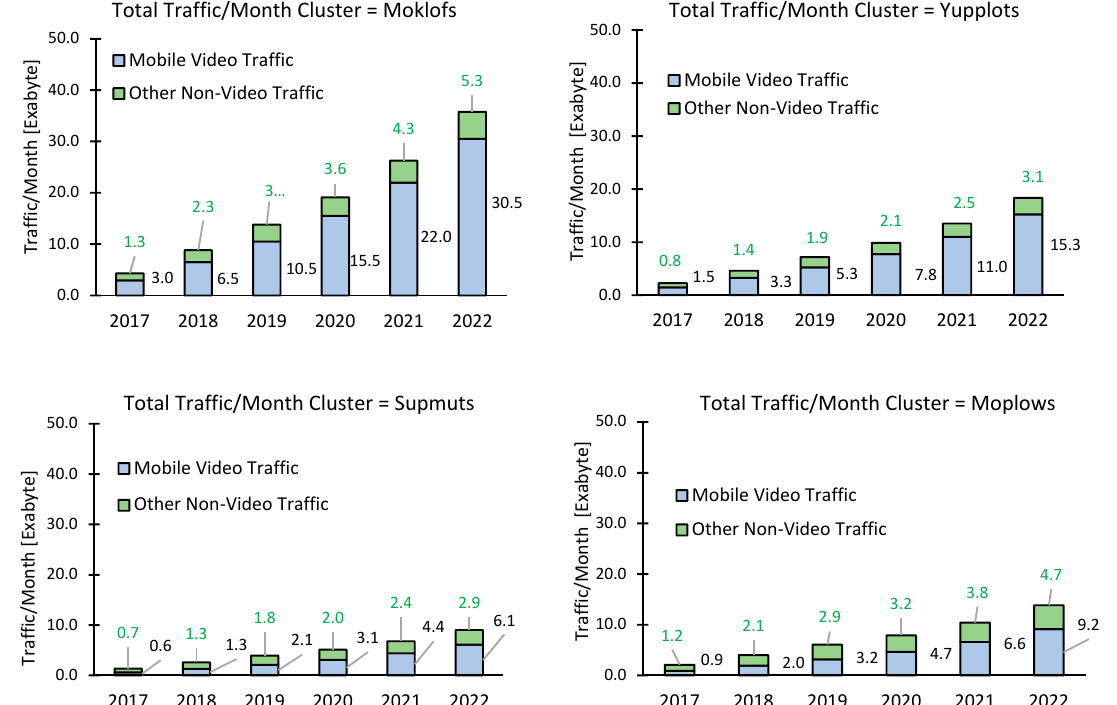
Figure 11. Traffic generation breakdown per month and per behavioral cluster, over 6 years.